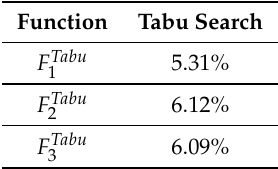
Table 5. Minimum damping of the SING with Tabu